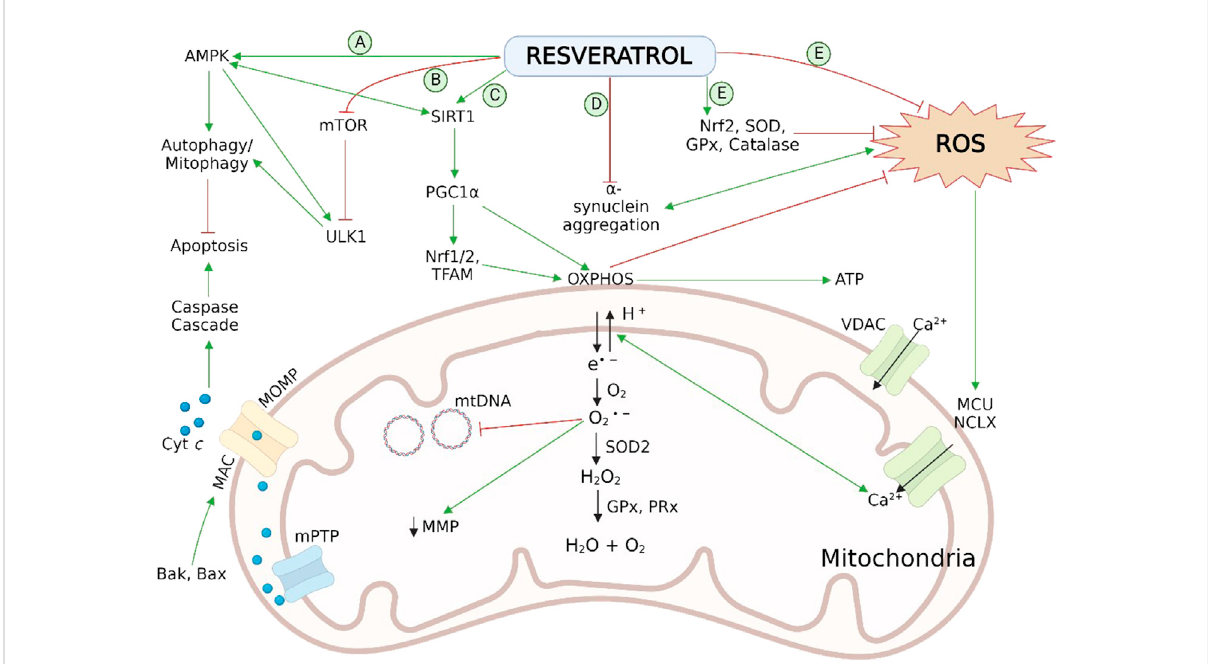
FIGURE 3 NeuroprotectiveeffectofRESinPDpathogenesis via reversalofmitochondrialimpairmentby (A) activationofAMPKand (B) inhibitionofmTOR and ULK1 leads to autophagy/mitophagyby recruiting autophagosomes followed by inhibition ofmitochondrial dependent apoptosis; (C) activation of SIRT-1-AMPK signalling pathway enhances the process of mitochondrial biogenesis by persuading PGC-1 α , Nrf1/2, and TFAM; (D) reduction in aggregation of α -synaggregation; (E) scavengingactiononcellularROSandactivation ofendogenousantioxidantenzymaticactivities.Normal physiologyofmitochondrialbioenergeticscomprisesthemitochondrialOXPHOSsystem,existontheinnermembrane,whichgeneratesATPtoful fi l the cellular energy requirements. During the OXPHOS process, leakage of electrons takes place from mitochondrial complexes I and III, and (cid:129) − generates the O2 byproducts. These radicals disrupt theCa 2+ homeostasis, inducesdamaging effect on mtDNA and,increases oxidative stressas well as apoptosis associated with mitochondria. Antioxidant mechanisms of mitochondria involves ROS-scavenging enzyme SOD2, GPx and PRx. AMPK, adenosine monophosphate-activated protein kinase; Bak, B cell lymphoma 2 (Bcl-2) homologous antagonist killer; Bax, Bcl-2-associated X protein; cyt c, cytochrome c; GPx, glutathione peroxidase; HO-1, heme oxygenase-1; IMS, intermembrane space; MAC, mitochondrial apoptosis- induced channel; MCU, mitochondrial calcium uniporter; Mn-SOD (SOD2), manganese superoxide dismutase; MOMP, mitochondrial outer membrane permeabilization; mPTP, mitochondrial permeability transition pore; mtDNA, mitochondrial DNA; mTOR, mechanistic (or mammalian) (cid:129) − target of rapamycin; NCLX, the mitochondrial Na/Li/Ca exchanger; Nrf1/2, nuclear respiratory factor 1 and 2; O2 , superoxide radical; OXPHOS, oxidative phosphorylation; PGC-1 α , peroxisome proliferator-activated receptor coactivator-1 α ; PRx, peroxiredoxins (scavenger and antioxidant)